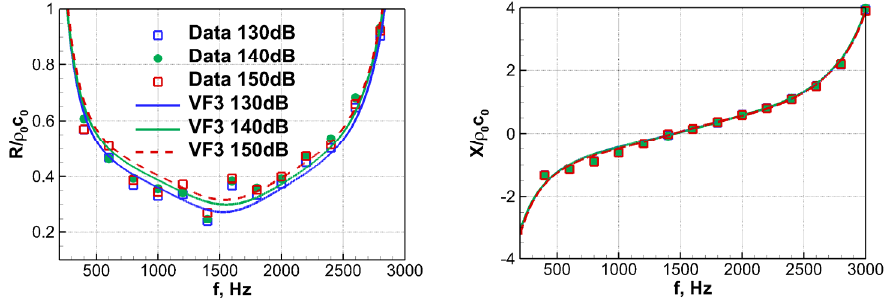
Figure 7. Acoustic resistance and reactance of AE02 liner at M AV = 0.4 and different levels of wall- pressure fl uctuations.